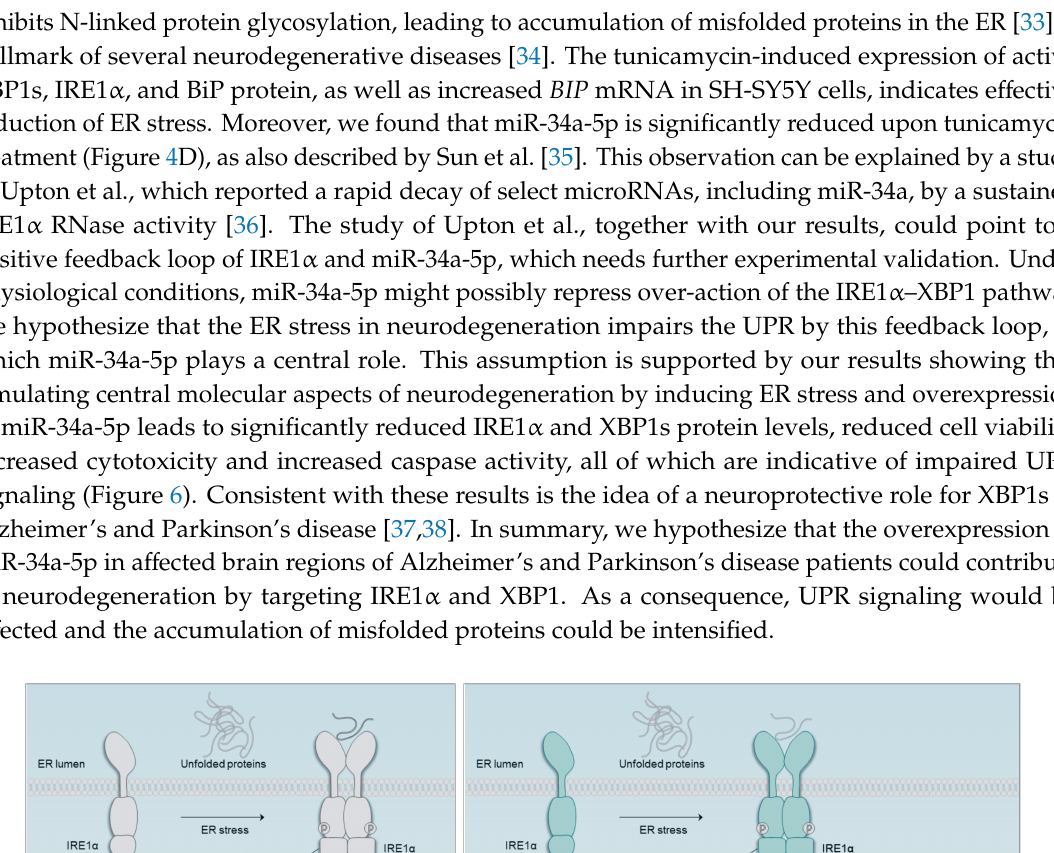
Figure S1: similarity heatmap for IRE1-mediated unfolded protein response (GO:0036498) by GeneTrail2 analysis. Figure S2: induction of UPR signaling in neuronal SH-SY5Y (A) and HEK293T cells (B). Figure S3: analysis of miR-34a-5p overexpression in SH-SY5Y cells by northern blot. Figure S4: results of the caspase 3 / 7 assay (A), cytotoxicity assay (B) and viability assay (C) in miR-34a-5p-transfected SH-SY5Y cells treated with DMSO. Table S1: results of the GeneTrail2 analysis for similar categories to IRE1-mediated unfolded protein response (GO:0036498). Table S2: sequences of cloning and mutagenesis primer. Table S2: sequences of cloning and mutagenesis